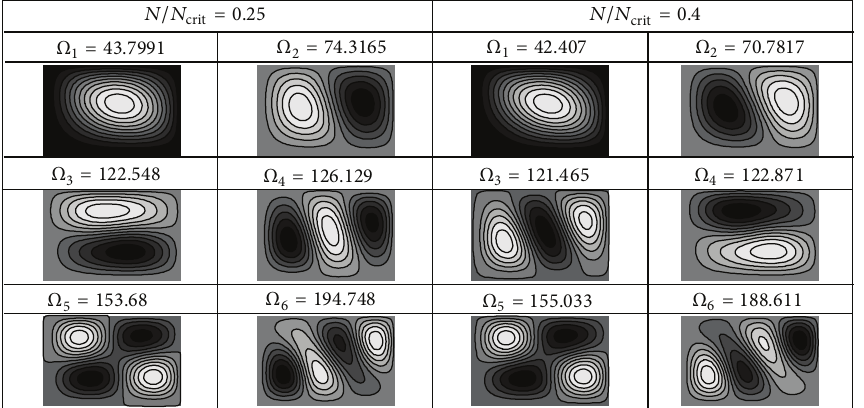
Figure 4: Normal modes of vibration of a rectangular C-C-SS-SS plate under uniform 𝑁 𝑥𝑦 loading ( 𝜆 = 𝑎/𝑏 = 1.5 , 𝑁